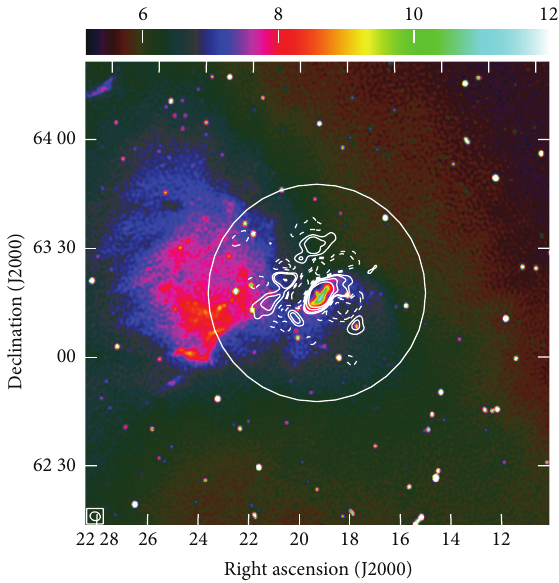
Figure 7: AME-G107.1+5.2: AMI SA data is shown as contours over CGPS 1.4 GHz pseudo colour, in brightness temperature. The pseudo-colour scale is truncated at 12K ( ≃ the peak brightness of S140) to show the low-surface-brightness diffuse structures. on the AMI map AMI contours are at ± 5, 10, 25, and 50 𝜎 rms (0.34 mJybeam −1 ). The 1 ∘ Planck smoothing scale is shown as the large circle, and the AMI SA synthesised beam is shown at the bottom left